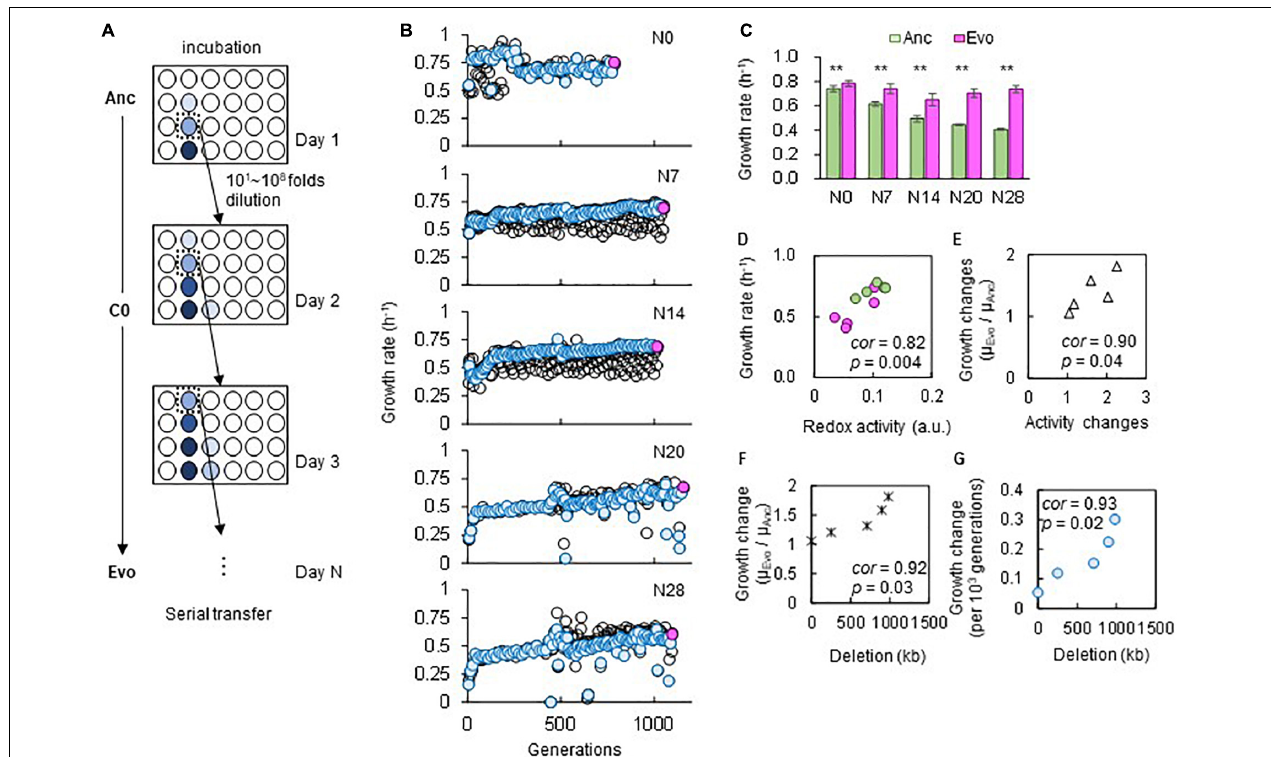
FIGURE 2 | Experimental evolution for adaptation to C0. (A) Illustration of experimental evolution. The gradation from light to dark blue indicates the cell concentration from low to high. The E. coli cells were cultured in eight wells, and eight 10-fold serial dilutions were prepared. Only one of the eight wells (dilutions) showing growth in the early exponential phase was used for serial transfer, as indicated by dotted boxes. (B) Temporal changes in growth rates during the experimental evolution. The five genomes are indicated. The blue circles represent the lineages adopted for the following serial transfer, corresponding to the wells indicated by dotted boxes in (A) . The black circles stand for the remaining serial dilutions (i.e., the other seven wells) that were not adopted for serial transfer. The endpoint populations of the evolutionary lineages (blue circles) used for the following analyses are indicated in pink. (C) Growth rates in the medium for evolution. Green and pink bars represent the growth rates of Ancs and Evos in C0, respectively. Standard errors of biological replications ( N > 6) are indicated. Asterisks indicate the statistical significance of the two-tailed Student’s t -test ( p < 0.01). (D,E) Correlation between the growth rate and cellular redox activity. Green and pink circles represent Ancs and Evos, respectively. The Spearman rank correlation coefficients and statistical significance are indicated. (F) Correlation between the changes in growth rate and genome reduction. The lengths of the genomic deletions are plotted against the ratio of the growth rates of Ancs and Evos. The Spearman rank correlation coefficients and statistical significance are indicated. (G) Correlation between the changes in growth rate per generation and genome reduction. The Spearman rank correlation coefficients and statistical significance are